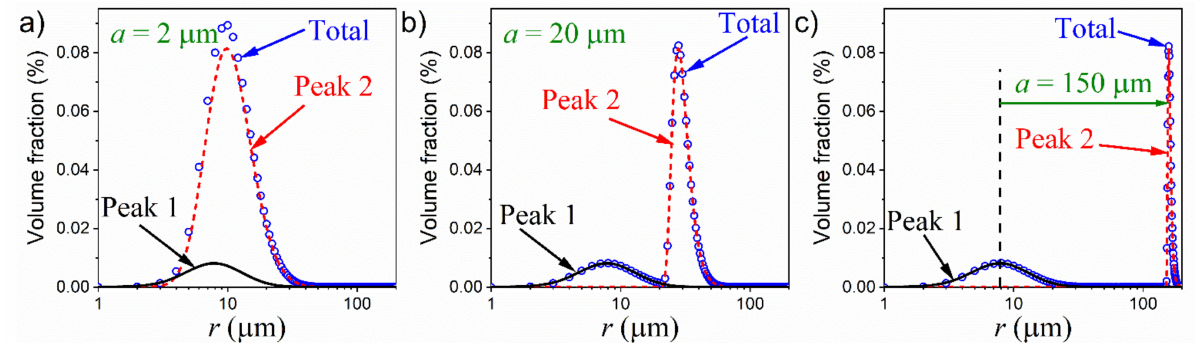
Figure 6. Bimodal particle size distributions using the simulations. The total PSD was calculated as the sum of two (cid:0) (cid:1) lognormal functions, with µ = ln 10 − 5 and σ = 0.5 being the amplitude of the second peak ten times the amplitude of the